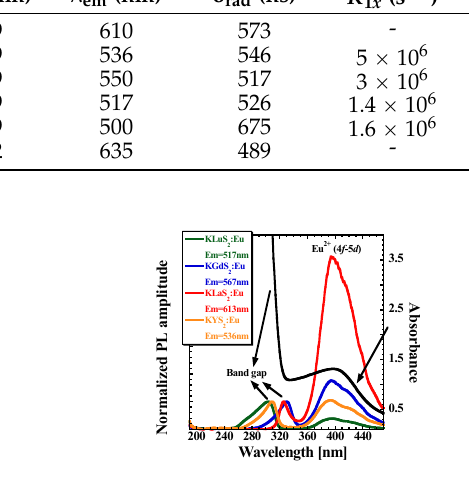
Table 4. Emission (PL) decay time temperature dependences and fit parameters of Eu 2+ in a selection of ALnS 2 :Eu. λ exc , λ em , ô rad , K ix and E ix are excitation and emission wavelengths, low-temperature limit of observed radiative lifetime, frequency factors and energy barriers of the emission quenching channels. For more details, see the text.